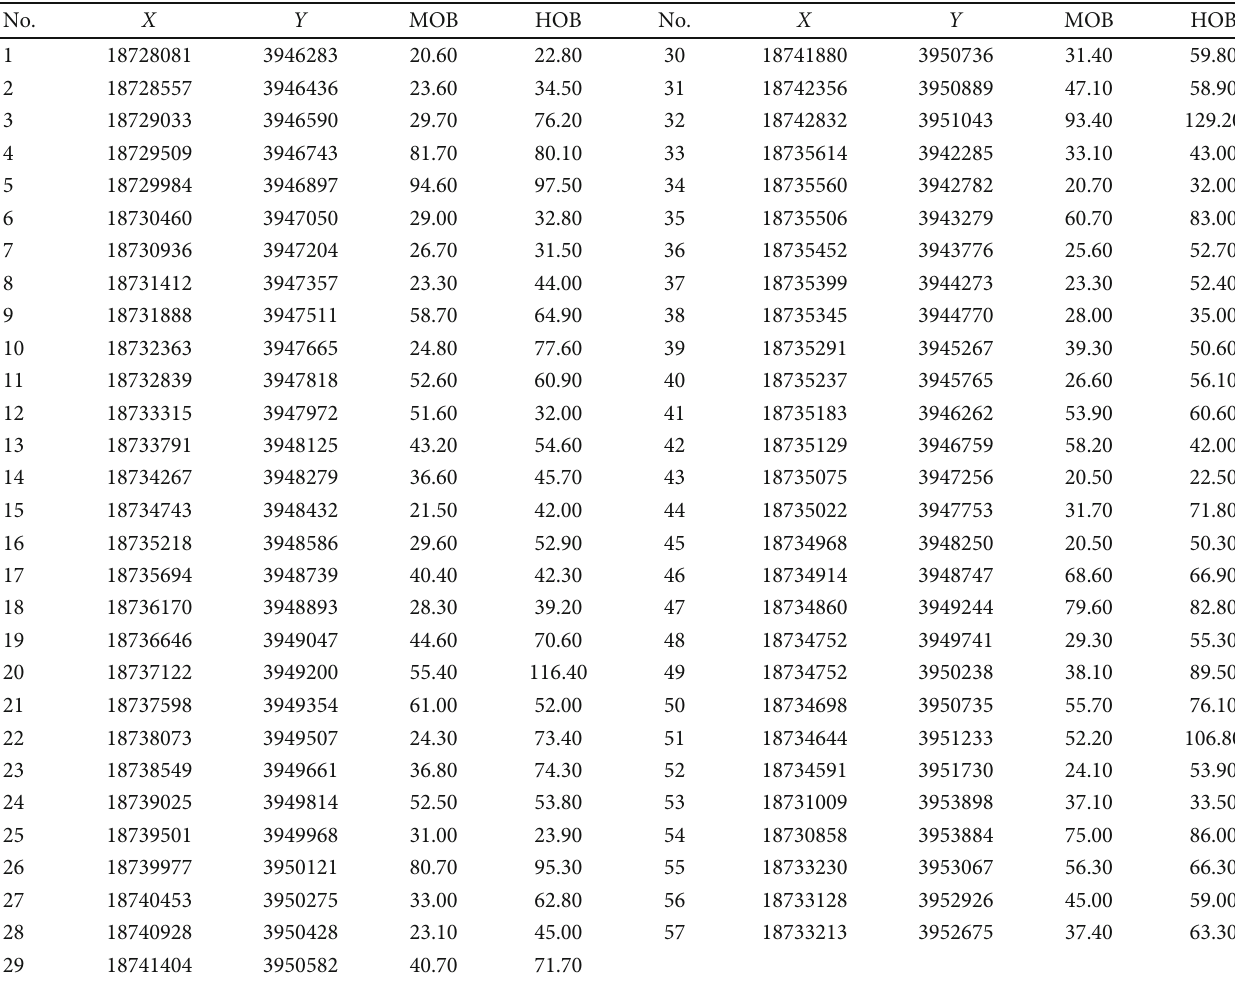
Table 2: Summary of MPOG data of Xifeng Oil fi eld in